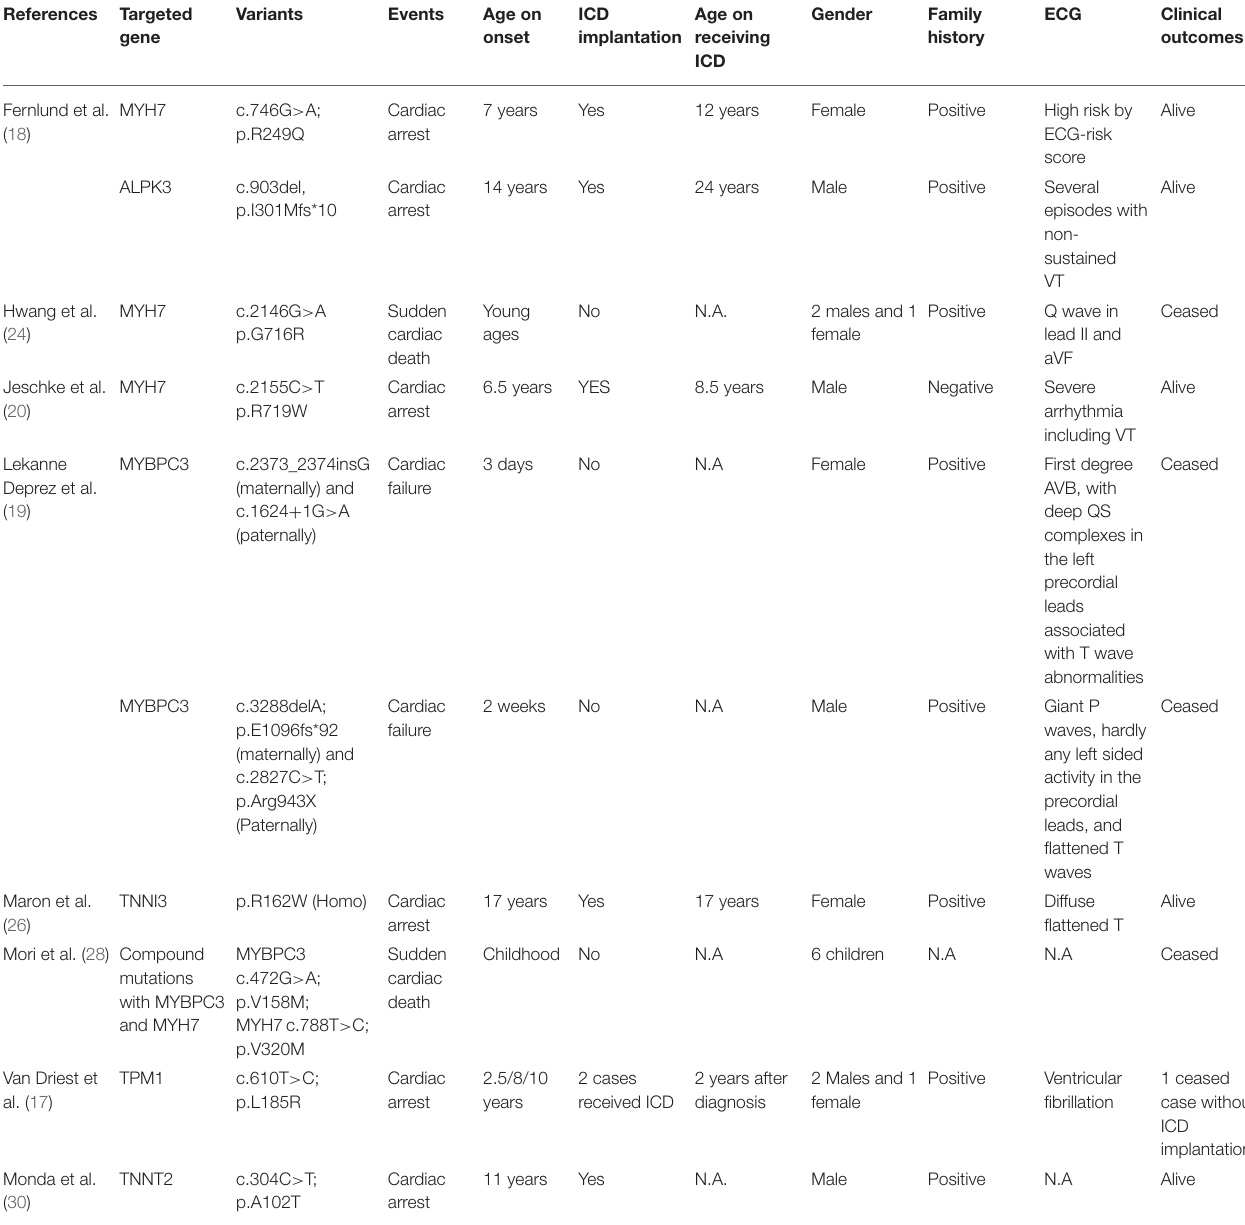
TABLE 1 | Association between gene mutations and malignant events in children of hypertrophic cardiomyopathy. References Targeted